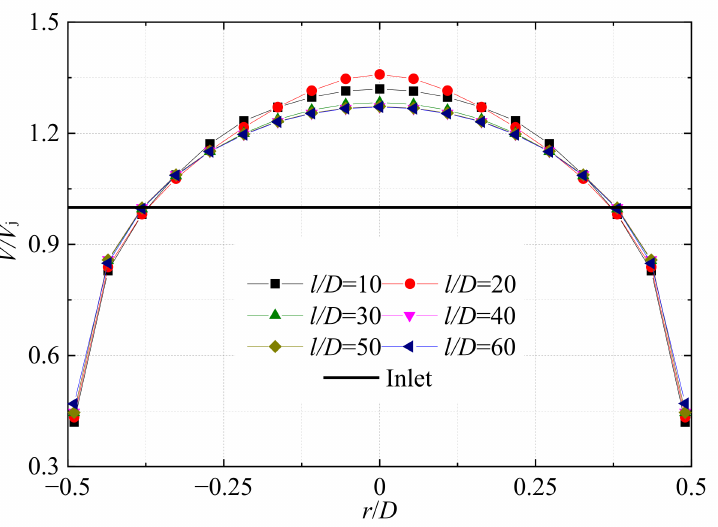
Figure 6. The radial distribution of the dimensionless velocity V/V j at different tube